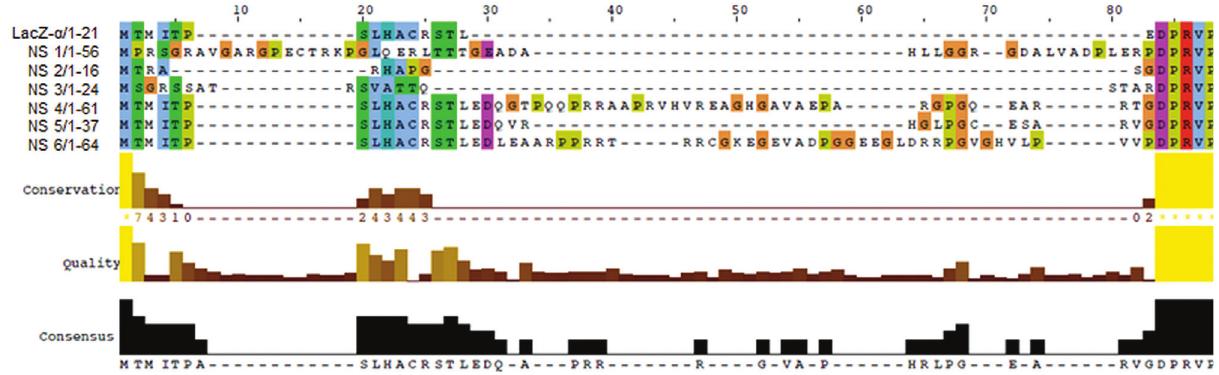
Figure 4 - Alignment of the N-terminal region of the chimeric peptides (NS1-NS9) and LacZ (cid:2) -peptide. Alignment was carried out with the T-COFFEE Multiple Sequence Alignment Server and visualization was done with the Jalview program. In general, there were no amino acids conserved along the N-terminal